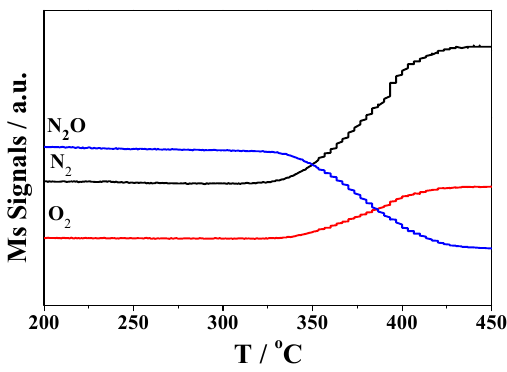
Figure 13. N 2 O ‐ TPSR profiles of Ru/Al 2 O 3 ‐ NaBH 4. Detection signals: 28 (N 2 ), 32 (O 2 ) and 44 (N 2 O). Figure 13. N 2 O-TPSR profiles of Ru/Al 2 O 3 -NaBH 4. Detection signals: 28 (N 2 ), 32 (O 2 ) and 44 (N 2